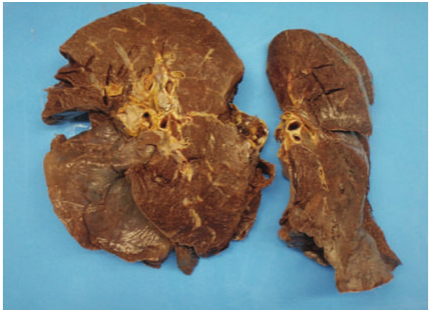
Figure 3: Lung cut surfaces showing bilateral heavy and hemor- rhagiclungs.Theleftlungweighed1050gramsandtherightweighed 1350 grams. Both lungs were macroscopically hemorrhagic which was confirmed on microscopy to be due to hemorrhagic